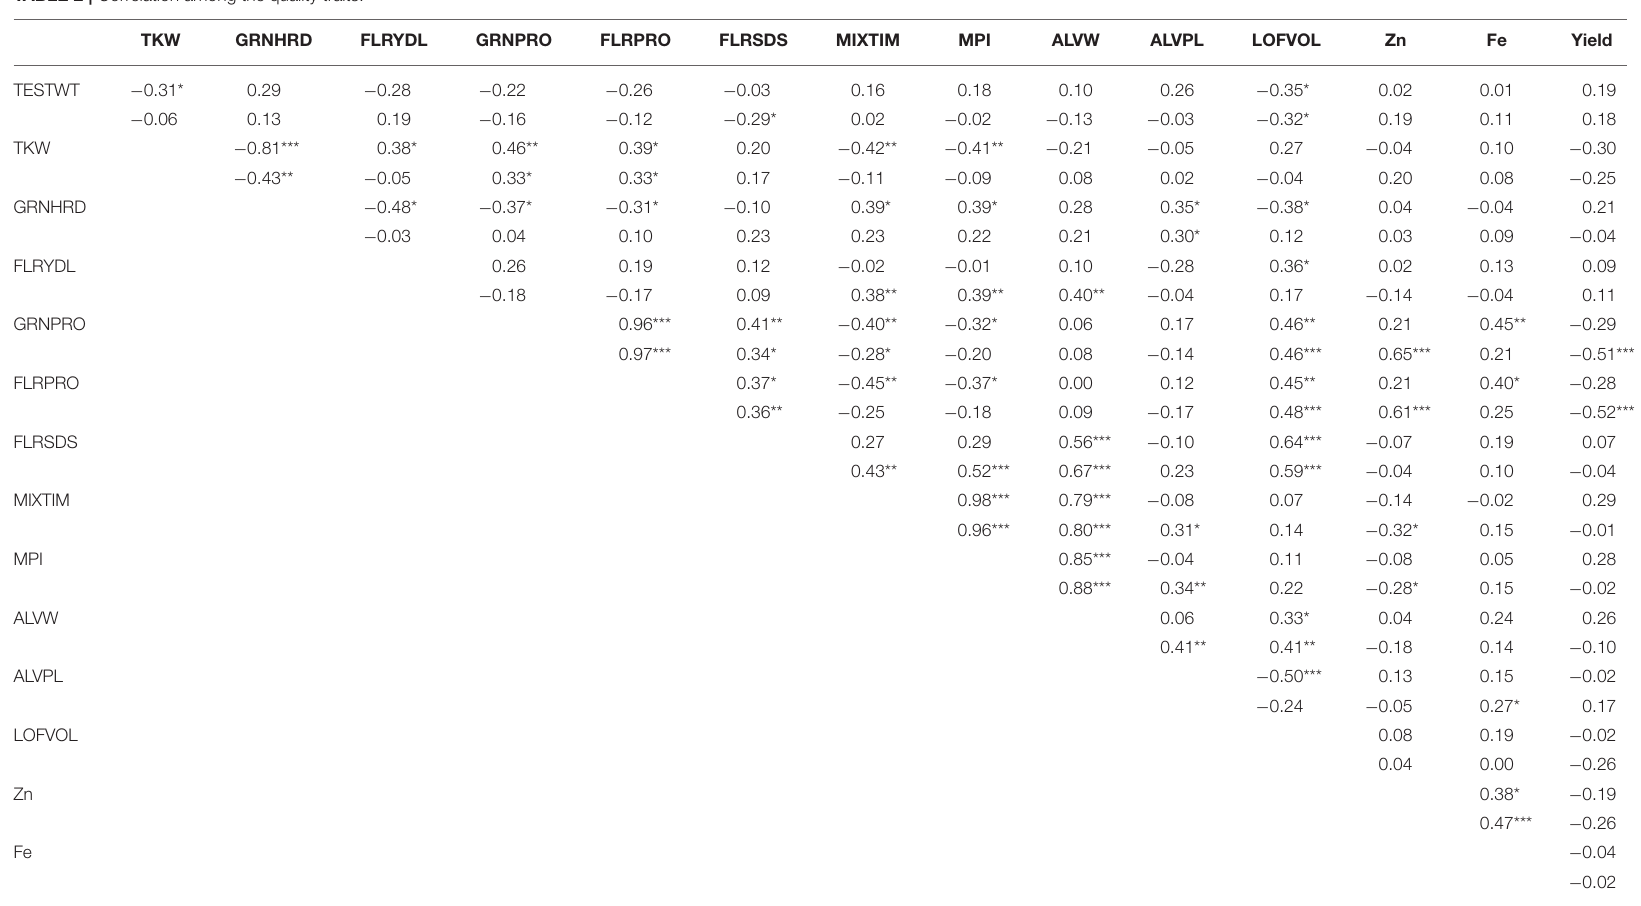
TABLE 2 | Correlation among the quality